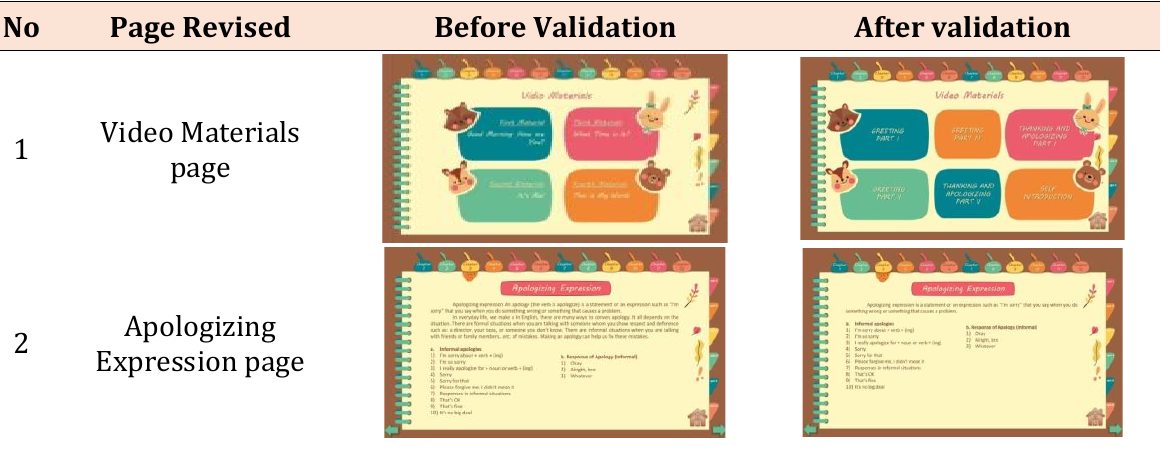
Table 4. Result of Product